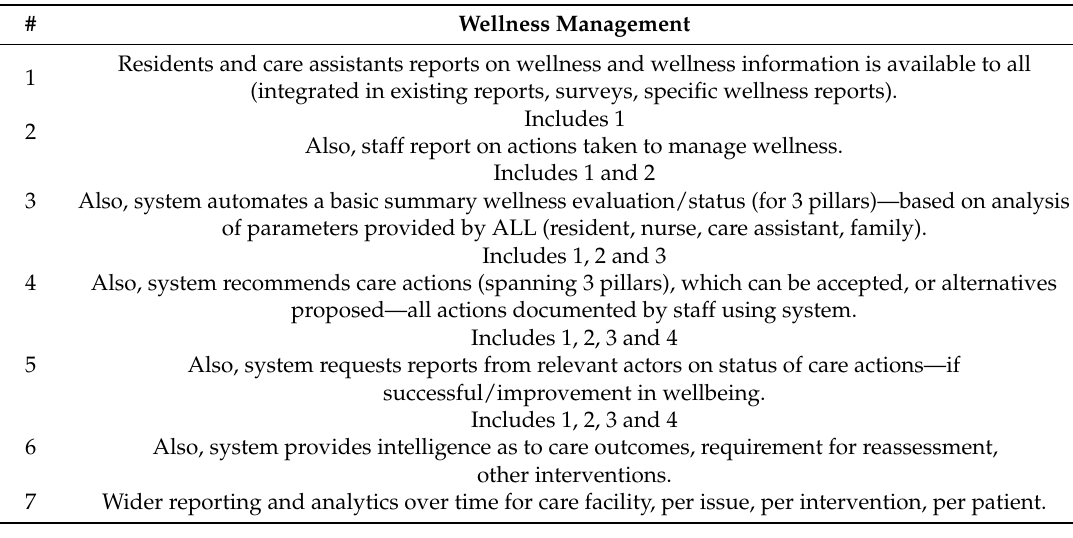
Table 4. Wellness management and technology intelligence levels.